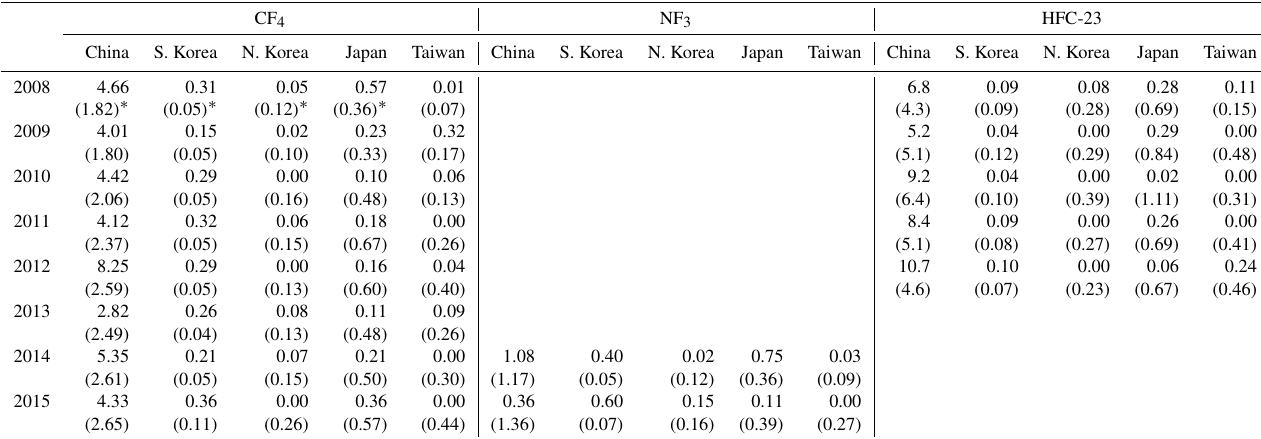
Table 1. Annual posterior emission estimates for the five main emitting countries surrounding GSN (Ggyr − 1 ). These posterior emission estimates are from the inversion that uses a prior emission uncertainty on each fine grid cell of 100 times the prior emission rate.